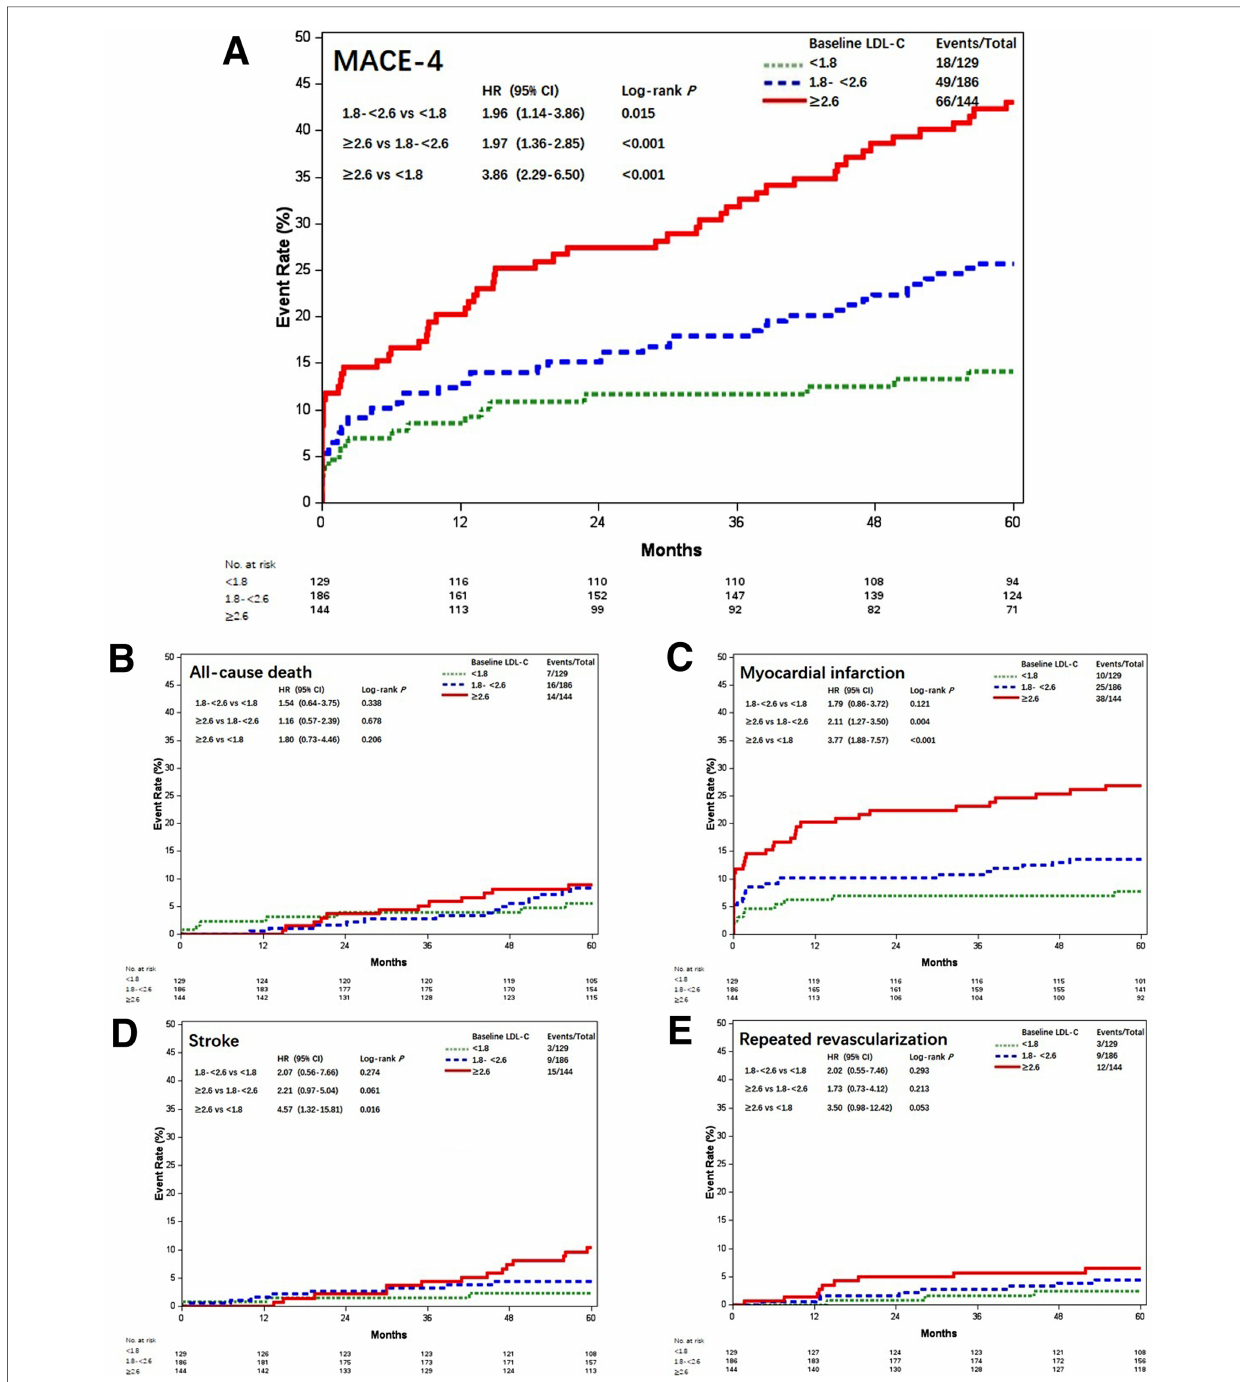
FIGURE 2 Kaplan – Meier curves of MACE-4 and each individual component among different postoperative LDL-C levels (mmol/L). Kaplan – Meier estimates for freedom from ( A ) MACE-4, ( B ) all-cause death, ( C ) myocardial infarction, ( D ) stroke, and ( E ) repeated revascularization. LDL-C, low-density lipoprotein cholesterol; MACE-4, 4-point major adverse cardiovascular